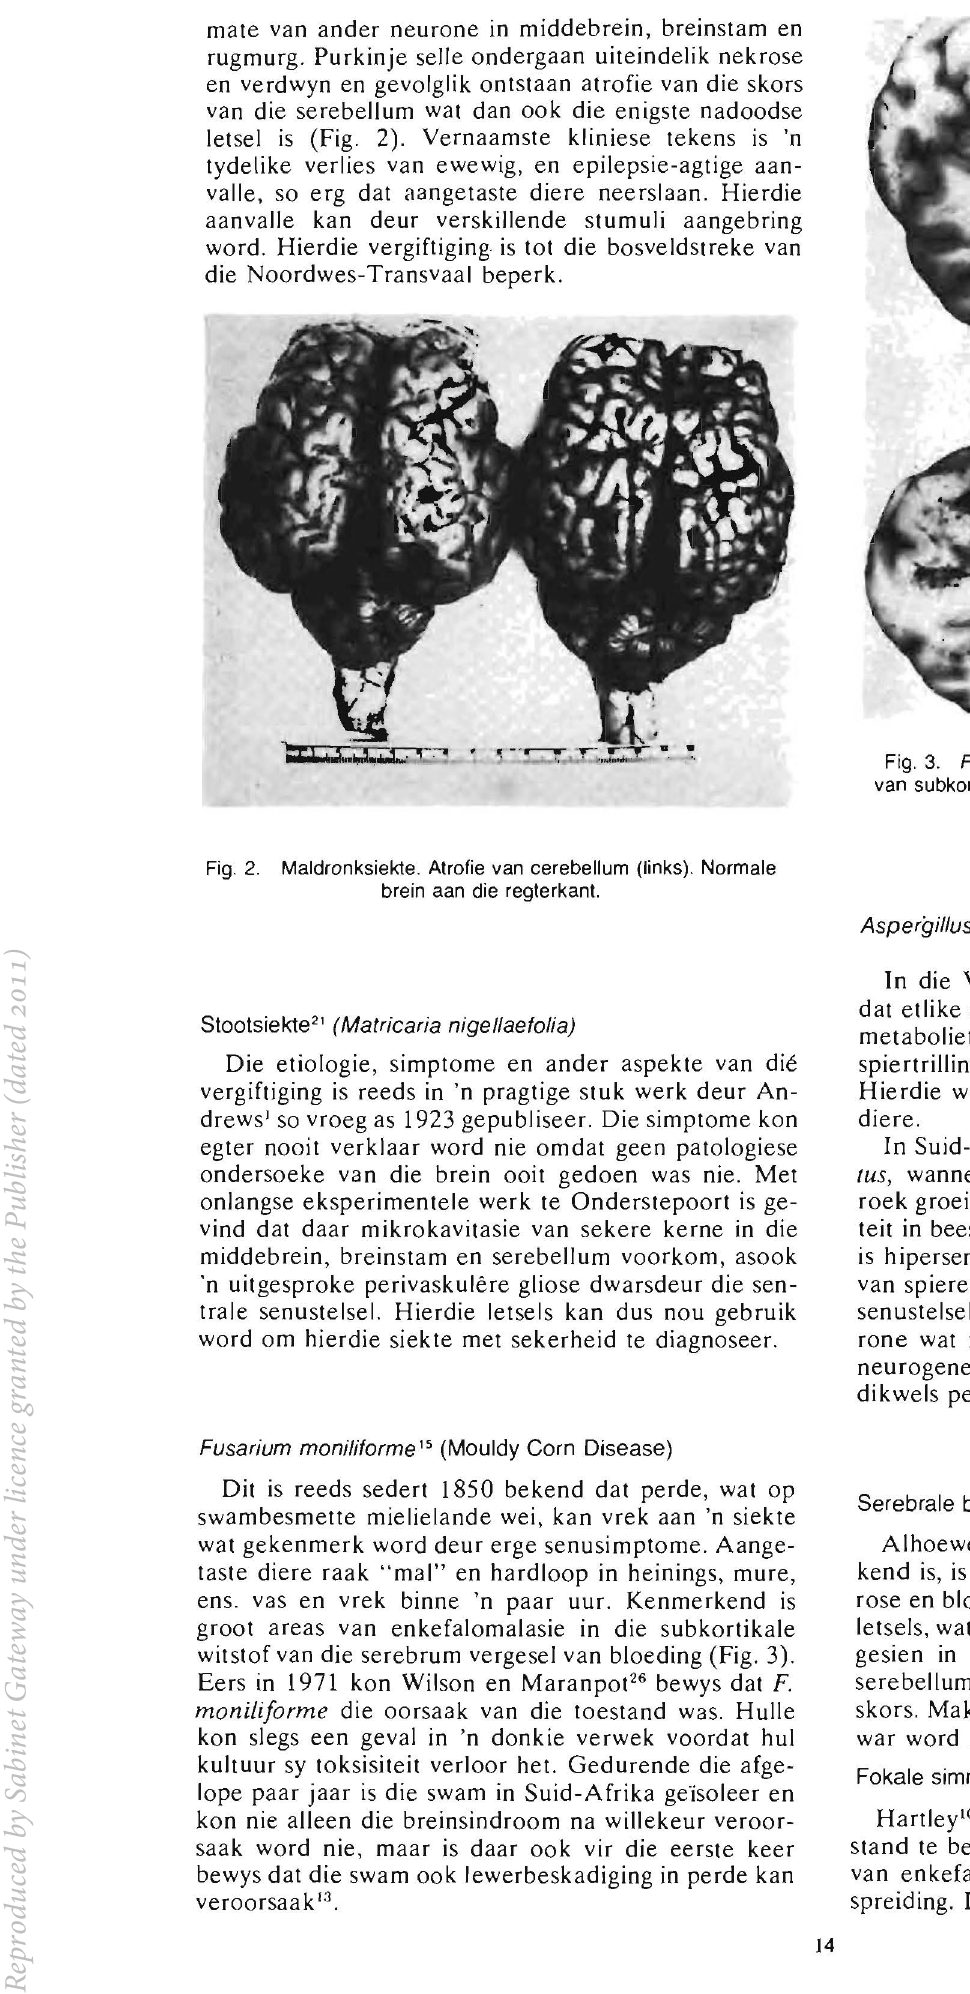
Dit is reeds sedert 1850 bekend dat perde, wat op swambesmette mielielande wei, kan vrek aan 'n siekte